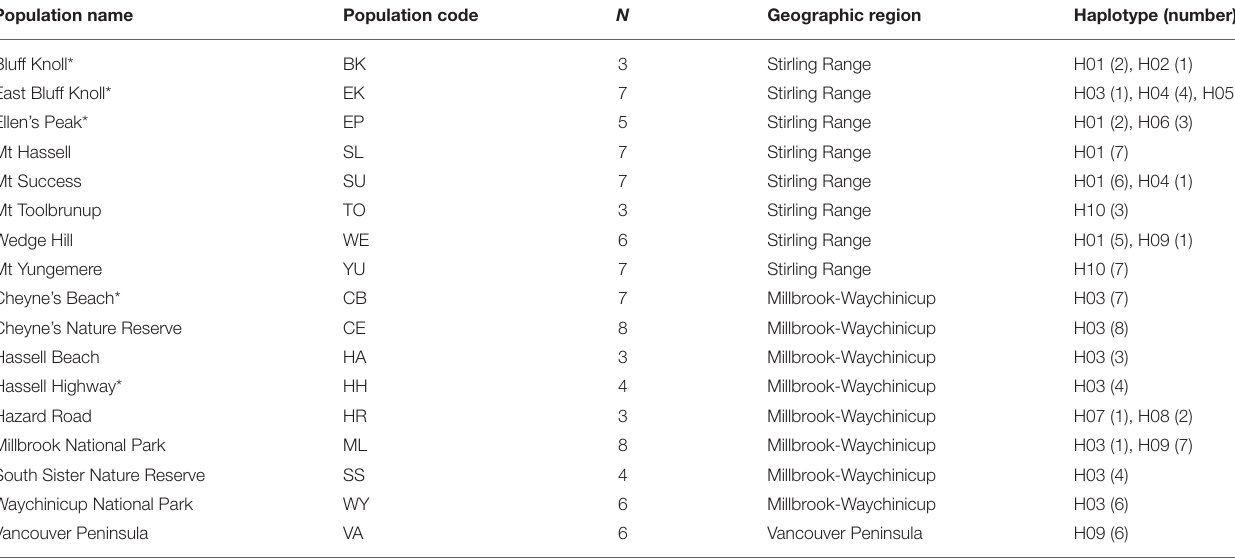
TABLE 1 | Details of sampled populations of Banksia brownii and haplotypes detected in each